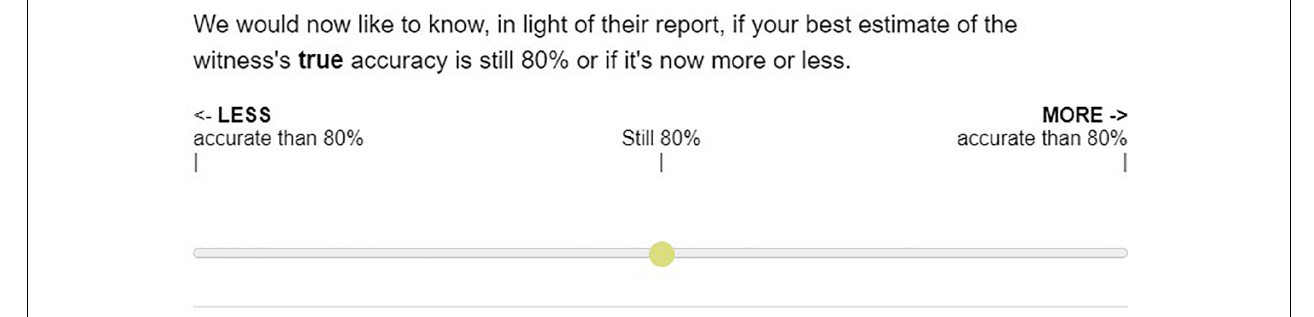
FIGURE 5 | Image of the slider mechanism used for participants to adjust their estimate for the witness.